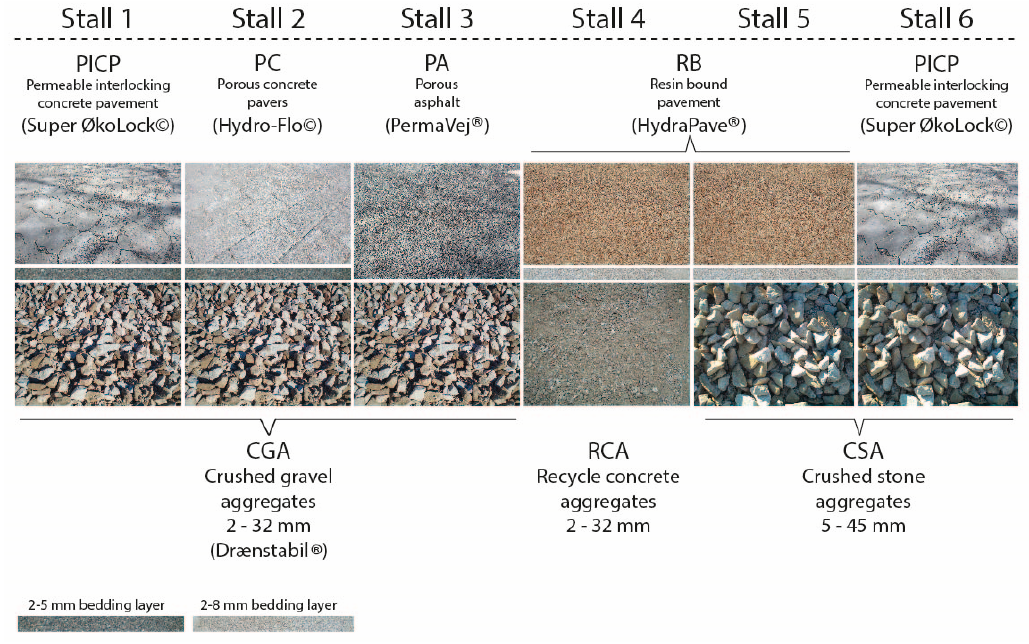
Figure 2. Diagram showing the combination of surface layer, bedding layer and sub-base layer of PP systems tested in six stalls, including photos of individual layer materials, where CGA = crushed gravel aggregates; RCA = recycled concrete aggregates; and CSA = crushed stone aggregates.